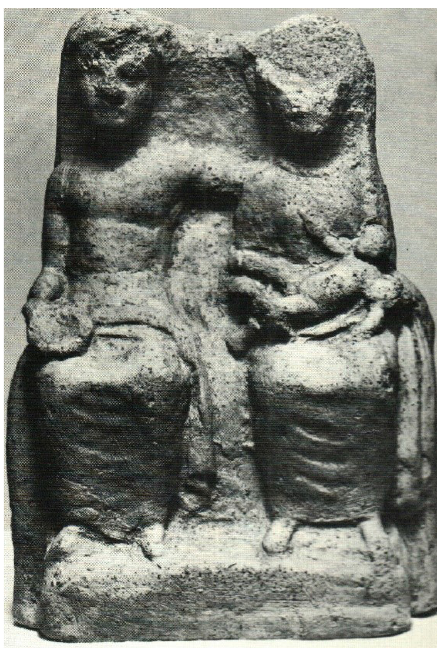
Figure 4. Veii Portonaccio. From Fridh-Haneson, “Le manteau”, 43, Pl. XII, Fig. 46. From Veii Campetti we have two further, unpublished, kourotrophoi with a male figure. They are both at the Villa Giulia Museum and likely date 4th century BCE. In the first one (Fig. 5, inv. n. 2498), the baby is similar to the one in Fig. 4. It is lying in the woman’s arms; its face is very close to her left breast and it reaches the woman’s right breast with its right arm. The man puts his left arm on the woman’s shoulders and holds a patera in the other hand. They likely wear a diadem; she wears a necklace. The other one (Fig. 6, inv. n. inv. 2458, previously VTP 607) shows a baby lying in the woman’s left arm; its face is very close to her left breast and it is covered by her mantle. She wears a necklace; he holds a patera in the right hand. They both wear a mantle, even though the two mantles seem to be unified.